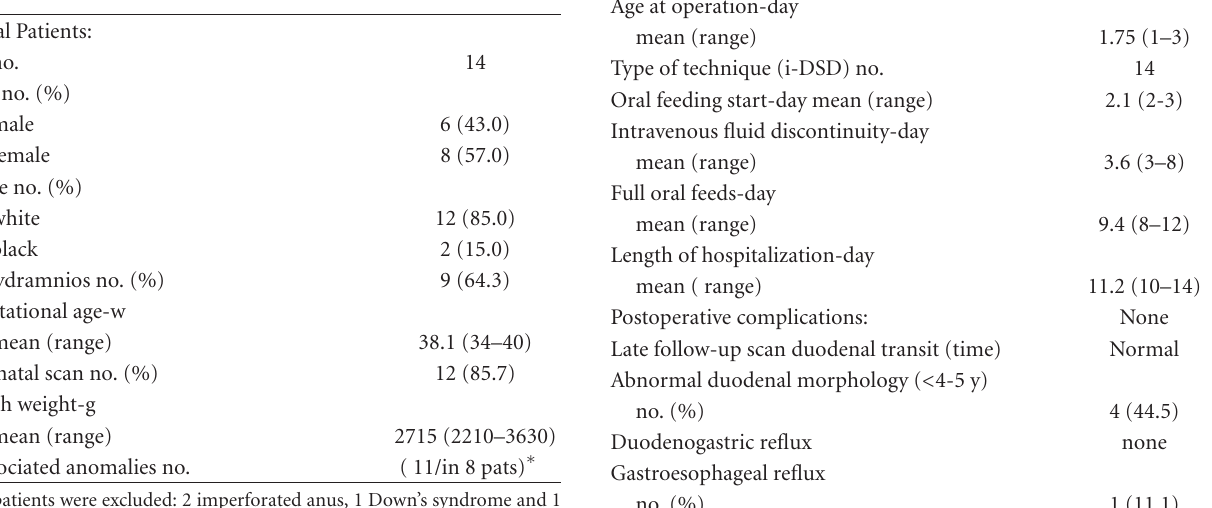
Table 1: Summary of clinical features in neonates with duodenal atresia (DA).